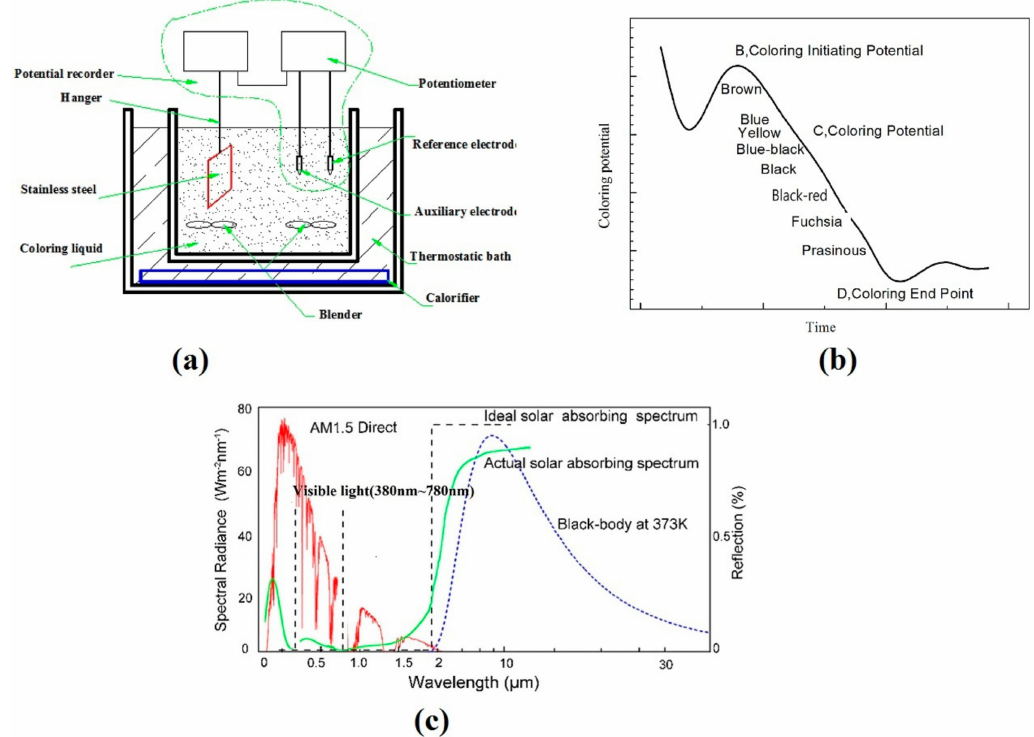
Figure 1. ( a ) Equipment drawing of chemical coloring; ( b ) coloring potential-time curves; ( c ) the spectrum of solar